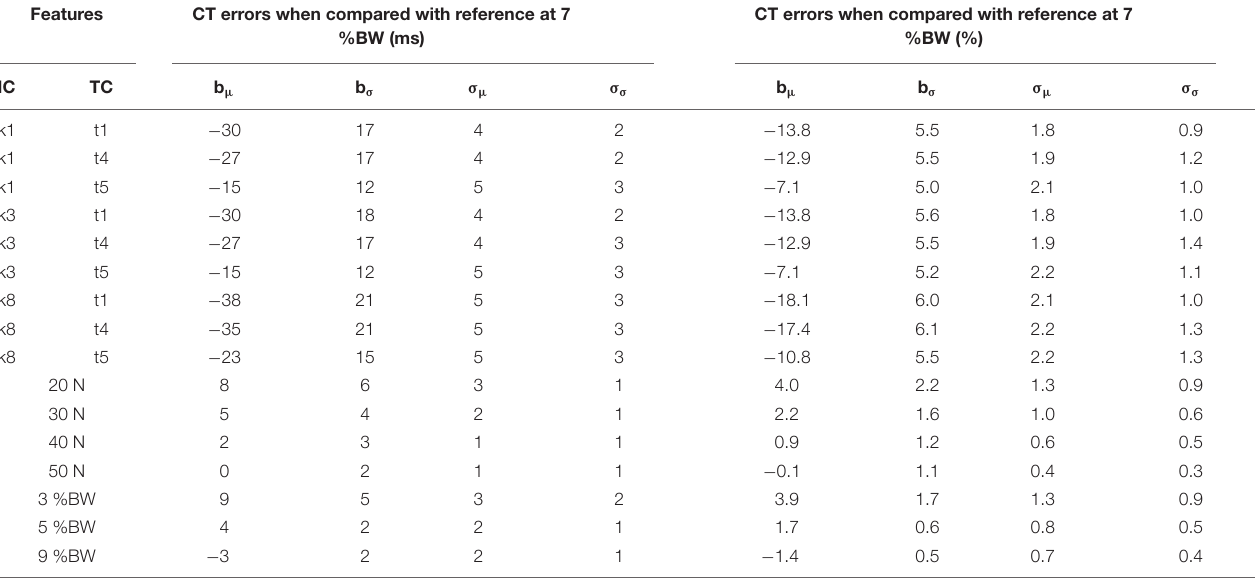
TABLE 3 | List of the duration differences for CT estimation in the validation set ( N = 146 trials, 12092 steps) when compared to the force plate estimation using the reference threshold set at 7 %BW. Features CT errors when compared with reference at 7 %BW (ms)